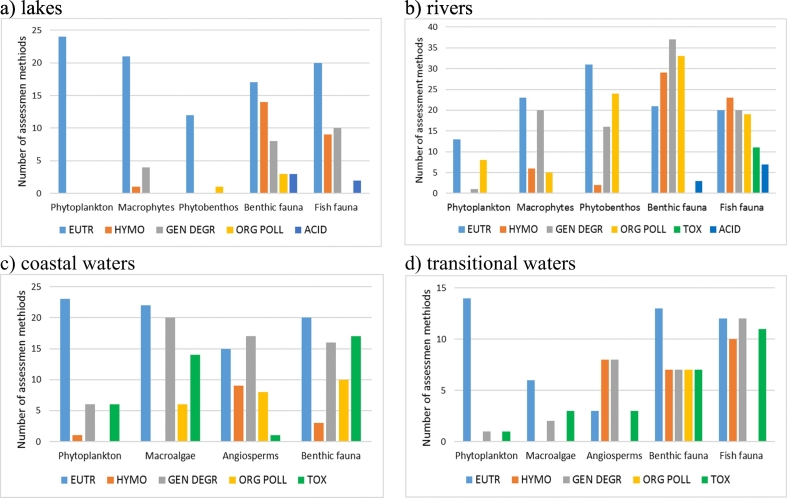
Sensitivity of BQE methods for different pressures for lakes, rivers, coastal and transitional waters (as reported by member states).EUTR: eutrophication; HYMO: hydromorphology; ORG POLL: organic pollution; TOX: toxicity; ACID: acidification; GEN DEGR: general degradation.